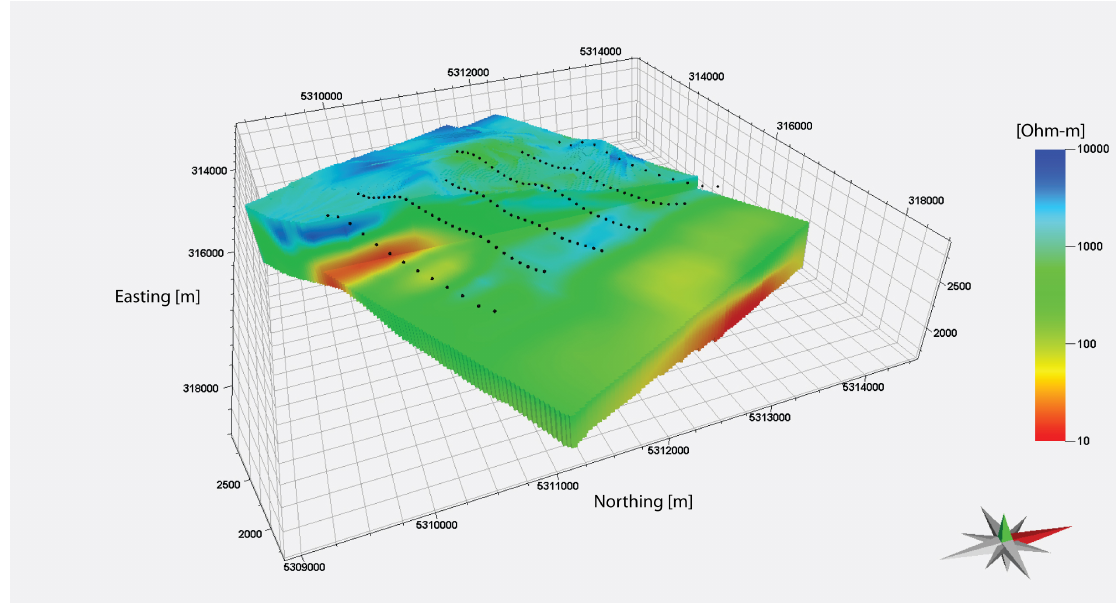
Figure 8. A 3D view of the 3D resistivity model recovered from 3D inversion of pole–dipole IP data.